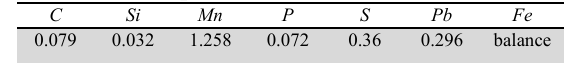
Fig. 2. Microstructure of free cutting steel AISI 12L14 (Optical micrograph) Mechanical properties of AISI 12L14